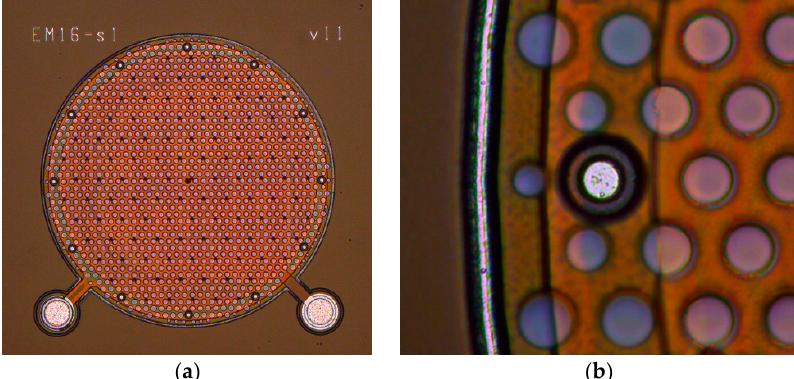
Figure 4. Microscope images: ( a ) Fabricated MEMS microphone; ( b ) Enlarged view of the dual